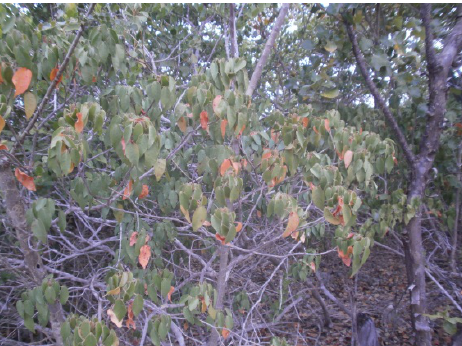
Figure 1. C. lucidus (in the State Dry Forest at Guanica , Puerto